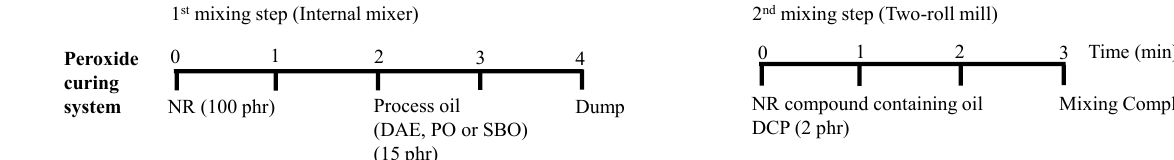
Figure 1. Mixing steps for the preparation of rubber compounds.